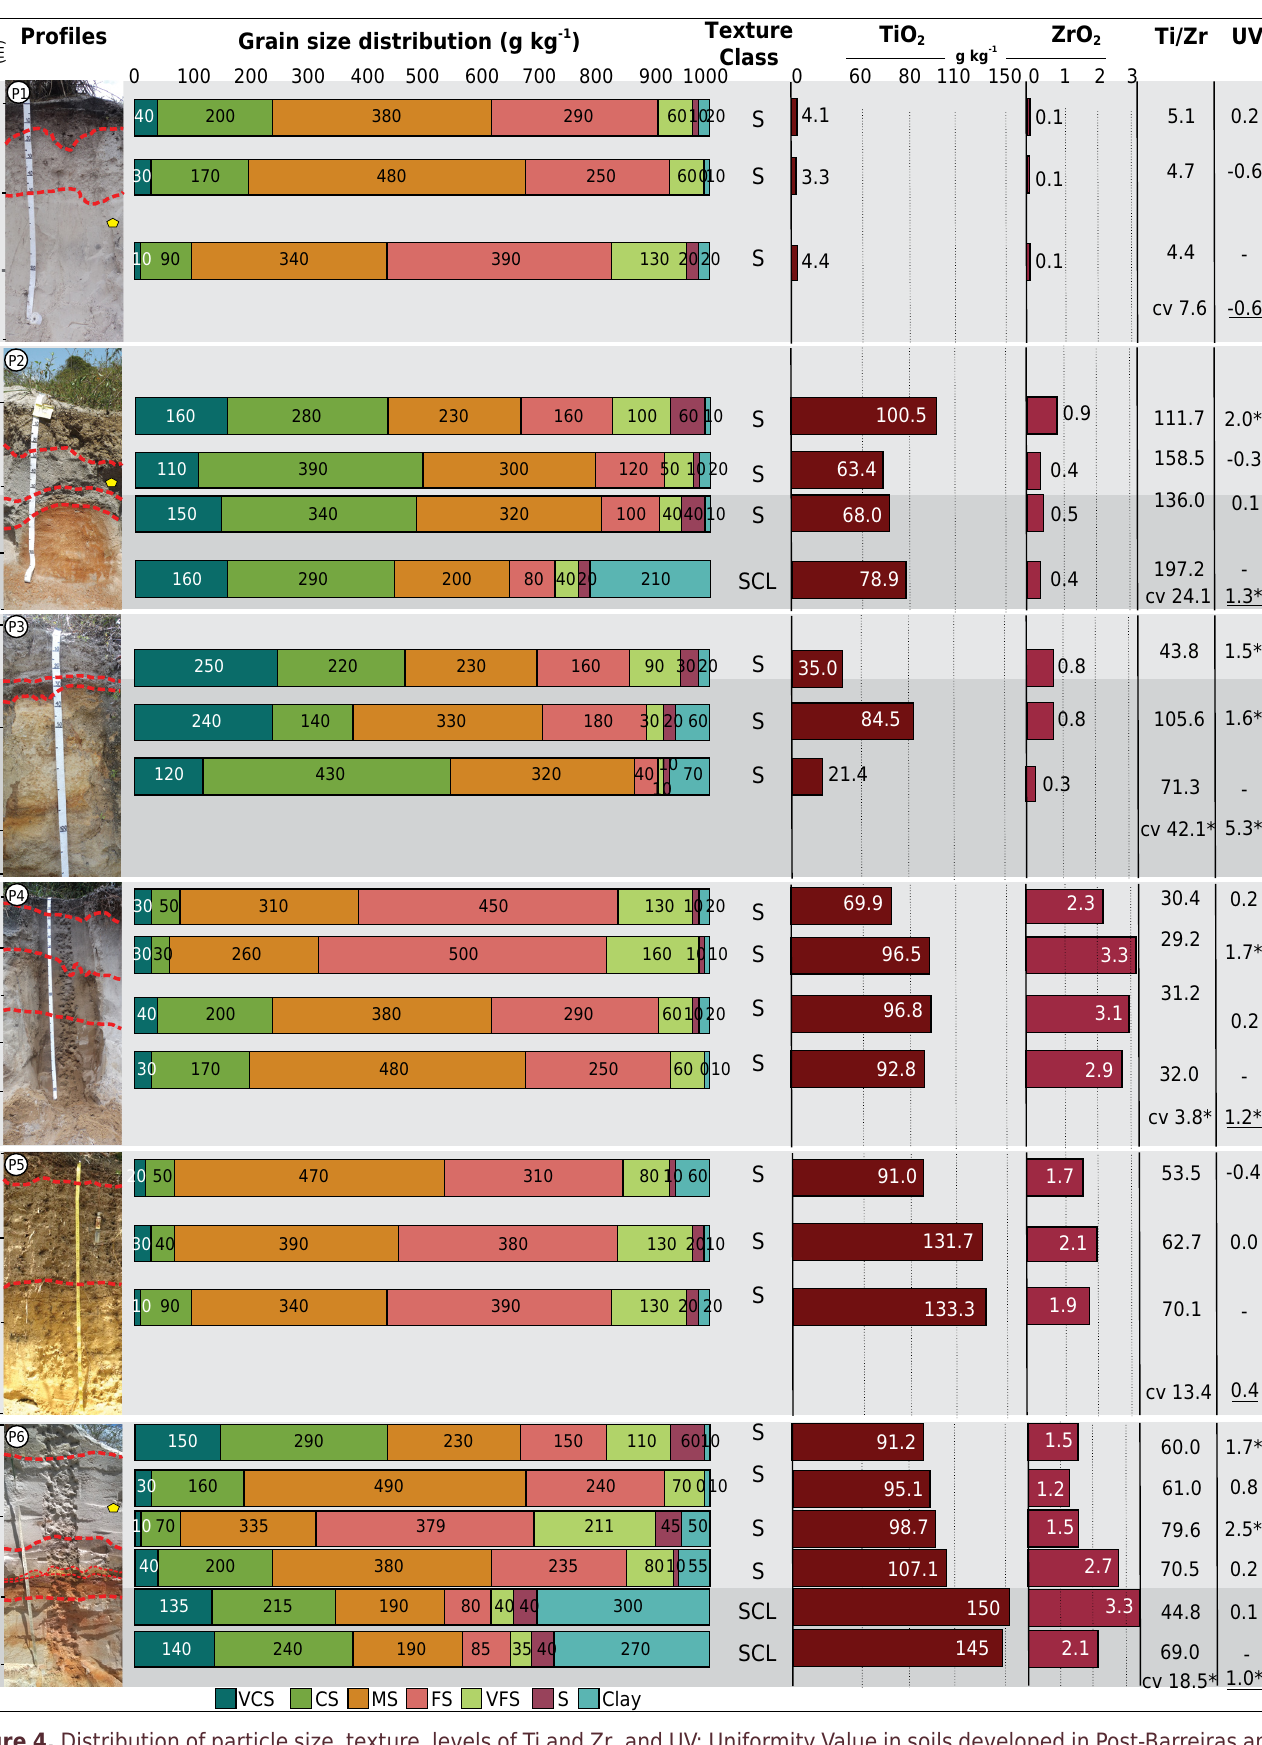
Figure 4. Distribution of particle size, texture, levels of Ti and Zr, and UV: Uniformity Value in soils developed in Post-Barreiras and Barreiras Formation sediments. Texture Class: S: Sandy; SCL: Sandy Clay Loam. * Indicative value of discontinuity and underlined UV values are calculated considering layers with morphological evidence of LD. Grain size classified as VCS: very coarse sand; CS: coarse sand; MS: medium sand; FS: fine sand; VFS: very fine sand; and S: very fine